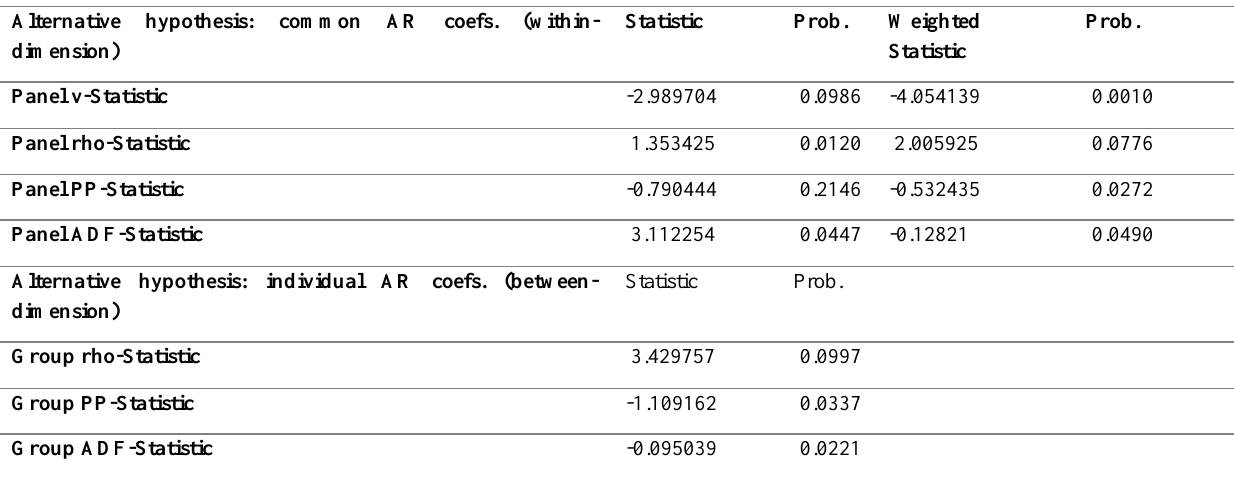
Table 4: Pedroni Panel Cointegration Test Without